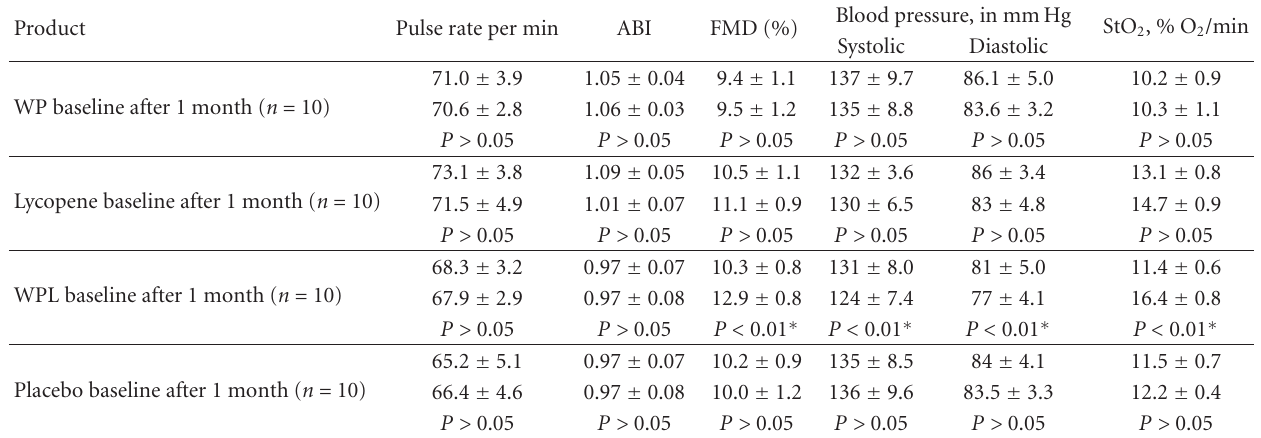
Table 4: E ff ect on cardiovascular